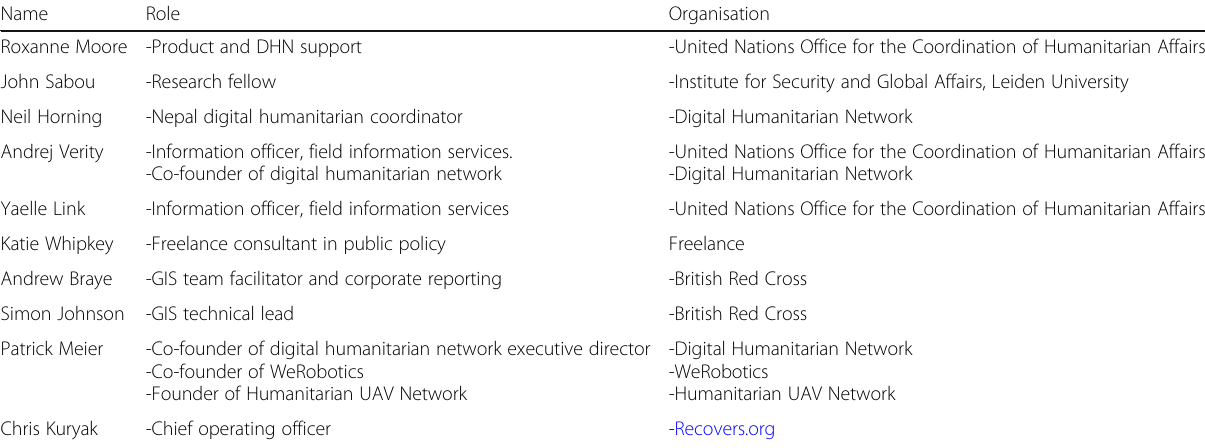
Table 1 List of interviewees and their respective organisations